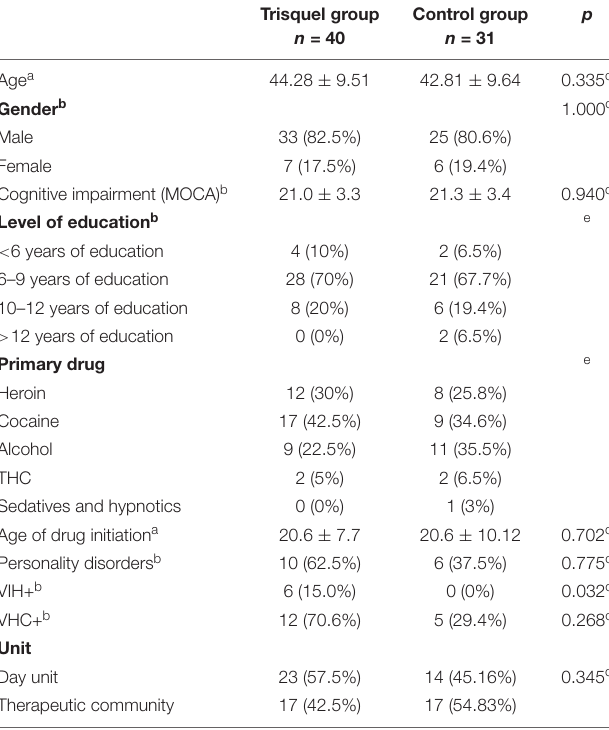
TABLE 2 | Descriptive analysis of sociodemographic